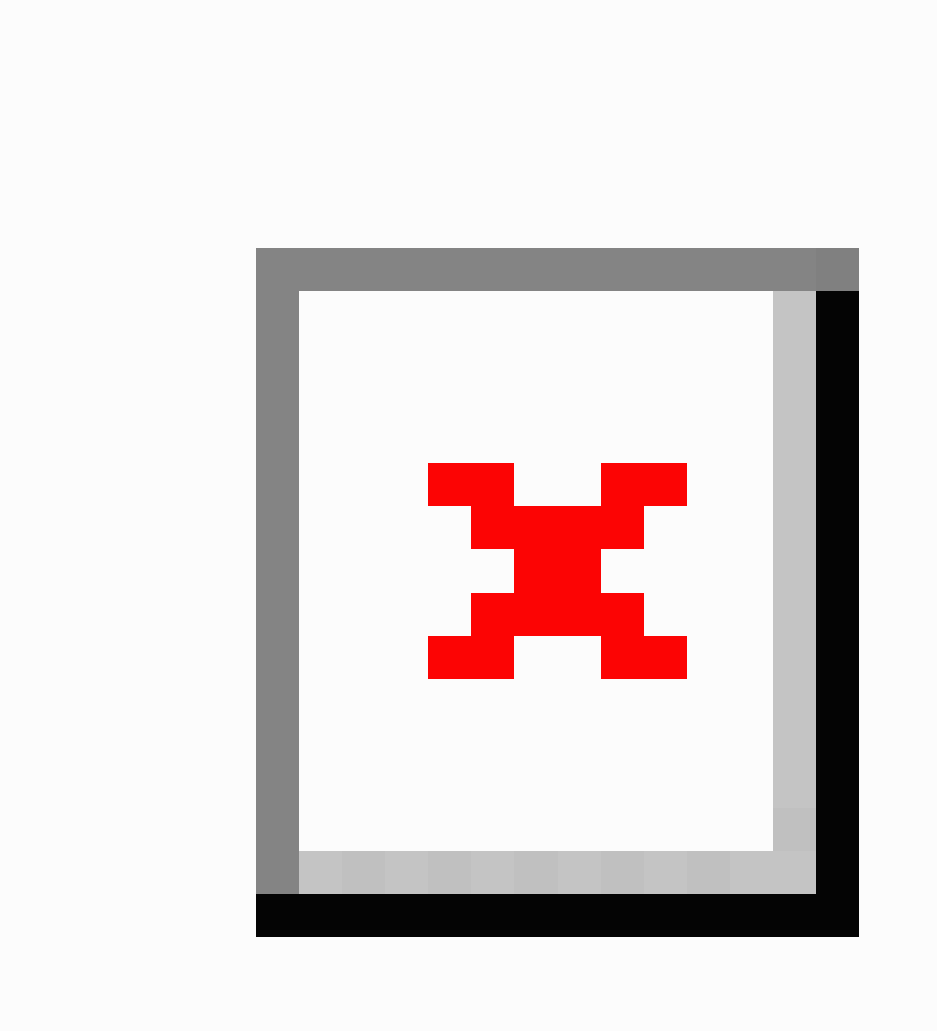
Figure 1. Screenshot of the lebensstil-aendern home